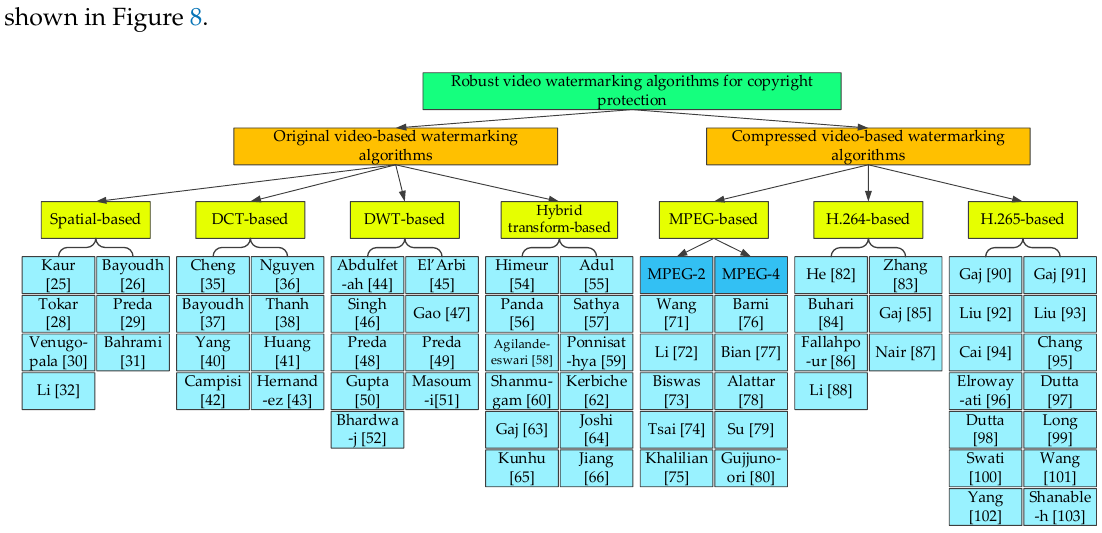
Figure 8. The research status of robust video watermarking algorithms for copyright protection.